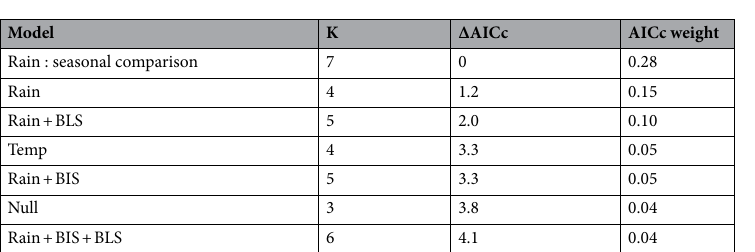
Table 1. Top models for consecutive seasonal comparisons within the same year (only models contributing ≥ 0.04 of the AICc weight are shown). For all models, elephant family group identity was included as a random effect. For consecutive seasons within the same year, the interaction between rainfall and specific seasonal comparison was explored. Temp temperature, BIS percentage of UD burned within season, BLS percentage of UD burned in last fire before season, TSLB time since last burn in UD before